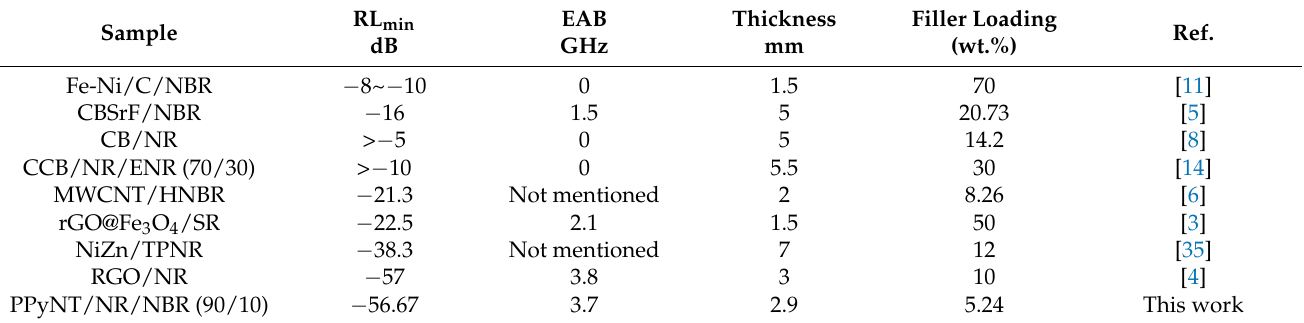
Figure 5. Three-dimensional RL plots for 6 phr PPyNT filled NR/NBR composites with different ratios of NR/NBR: ( a ) 10/90; ( b ) 30/70; ( c ) 50/50; ( d ) 70/30; ( e ) 90/10. Table 1. Comparison of the MA performance of the PPyNT filled NR/NBR (90/10) composite with other rubber-based absorbers in the frequency range of 8.2–12.4